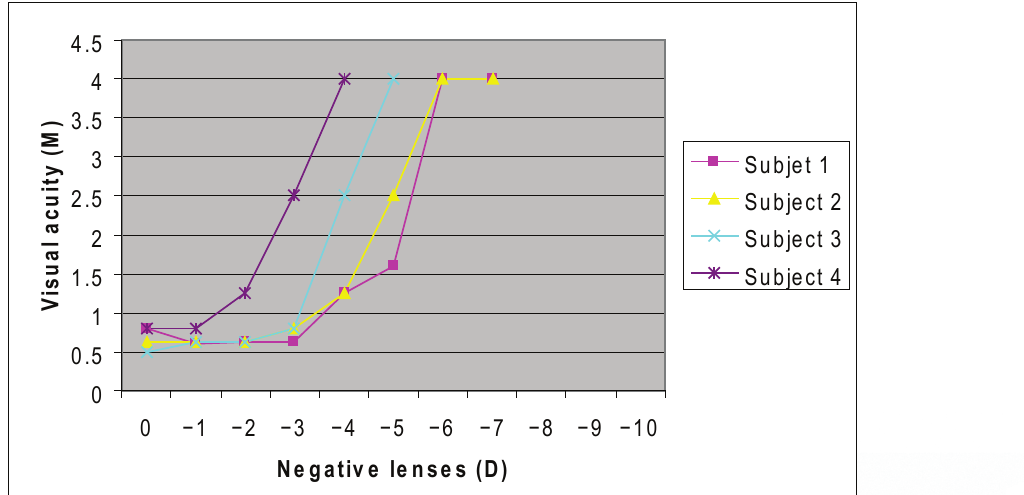
Figure 12. Effect of negative lenses on visual acuity while viewing a near acuity chart at 0.4 m through a pinhole with a 2 mm diameter and illumination of 1